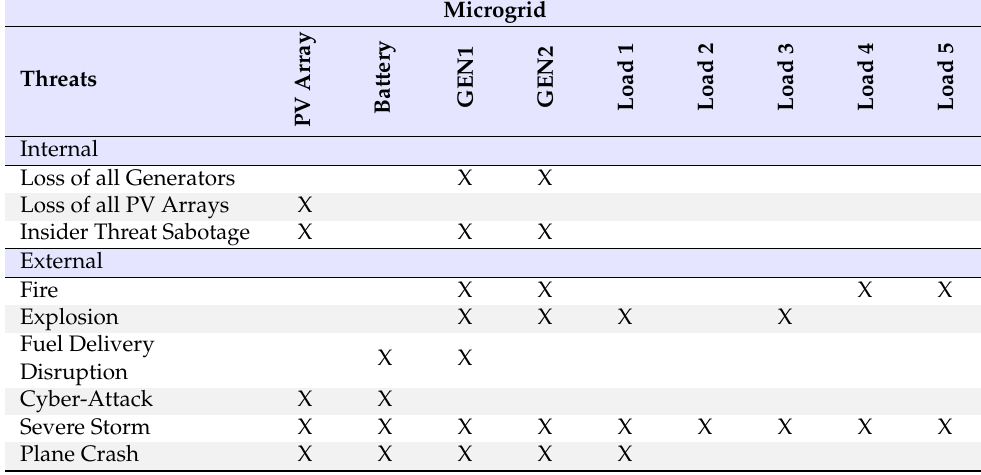
Table 6. Microgrid Threat Scenarios. The microgrid components that are offline, unavailable, or destroyed in each threat scenario are represented by an “X.”